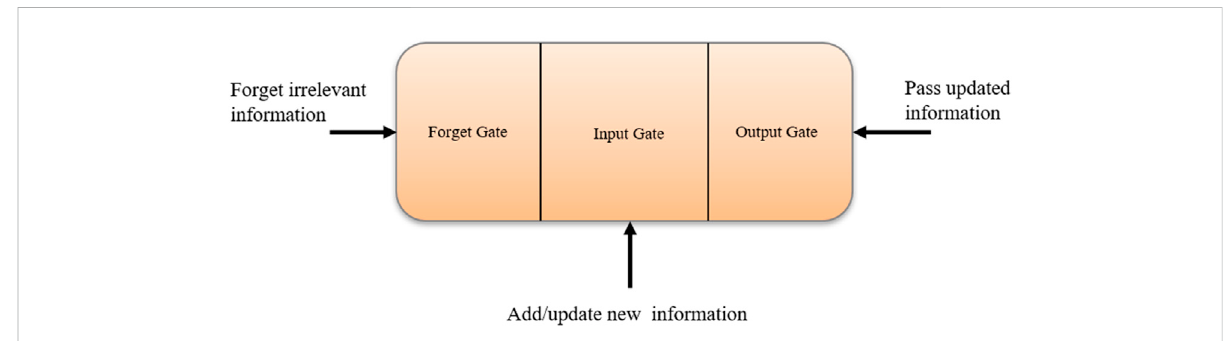
(cid:129) The forget gate forgets the